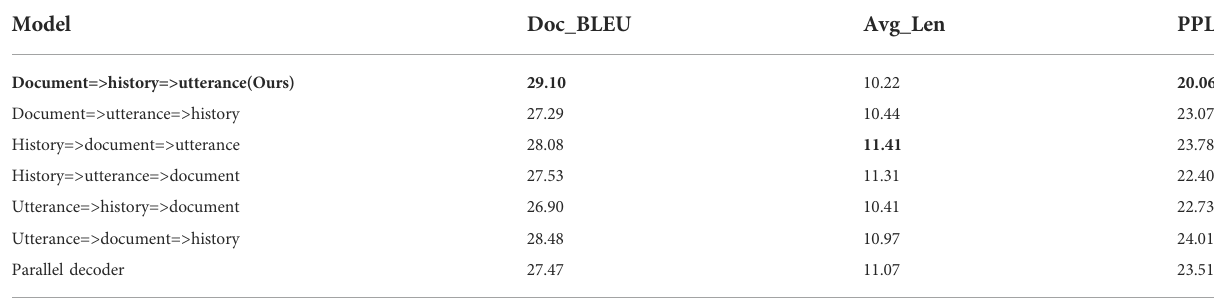
TABLE 7 Comparison of various decoding orders of the context on document relevance and response quality. The symbol “ = > ” represents the decoding order from the bottom up. Model